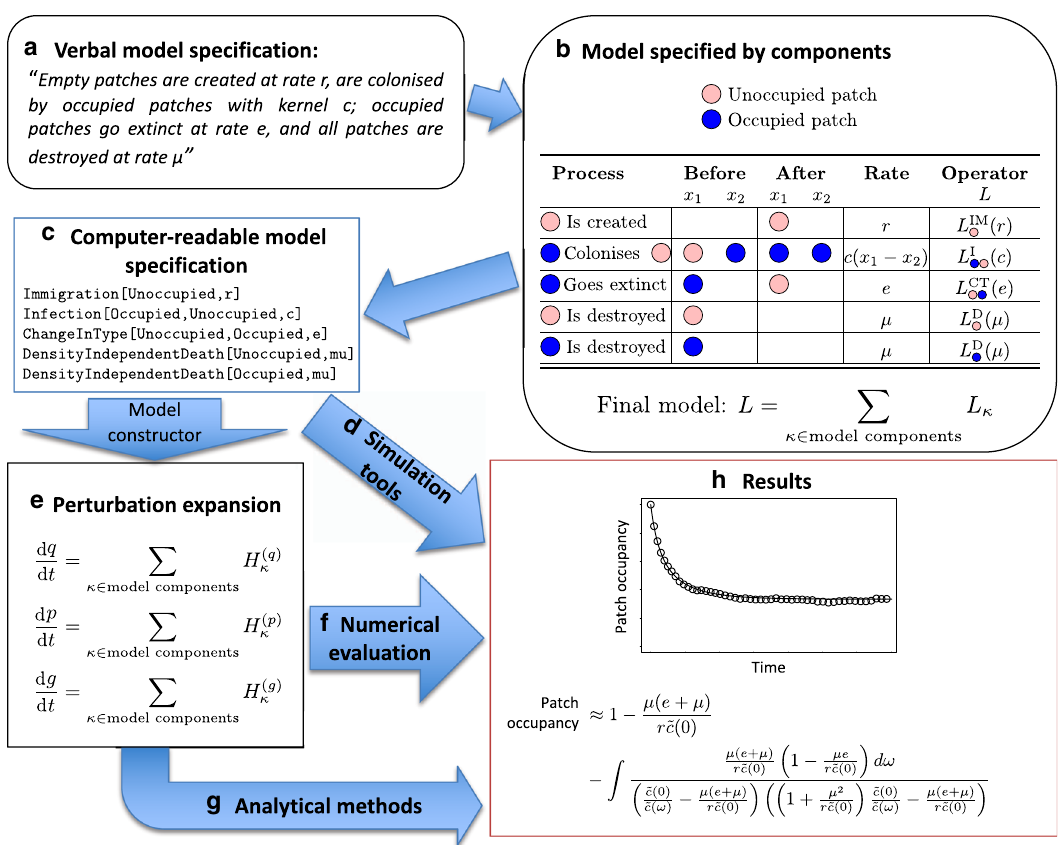
Fig. 2 Steps in our framework for constructing models and calculating their predictions. These are illustrated using our dynamic landscape metapopulation case study. The user wanting to study a particular model has only to convert the verbal model description ( a ) into a graphical model description ( b ), formulated in terms of a list of possible events and the rates at which they occur. An unambiguous mathematical statement of the model as a spatiotemporal point process is obtained from the operators L for these components 11 ; the superscripts denote the corresponding class of reactant – catalyst – product process, namely immigration (IM), infection (I), change of type (CT), density-independent death (D). The colour denotes the type of individual (blue: occupied patch; pink: unoccupied patch). A computer-readable statement of the components ( c ) can be used to generate code for simulating the model ( d ), or to derive the equations describing the perturbation expansion using computer symbolic algebra ( e ). The differential equations for the mean- fi eld q , correction p and spatial covariance g in the perturbation expansion comprise a sum of terms contributed by each of the model components. These expressions can then be evaluated numerically ( f ), or analysed further by human or machine ( g ). The predictions from simulations and mathematical methods can then be compared ( h ) and used in many ways to gain insights into the focal problem (see Figs. 3, 4 and